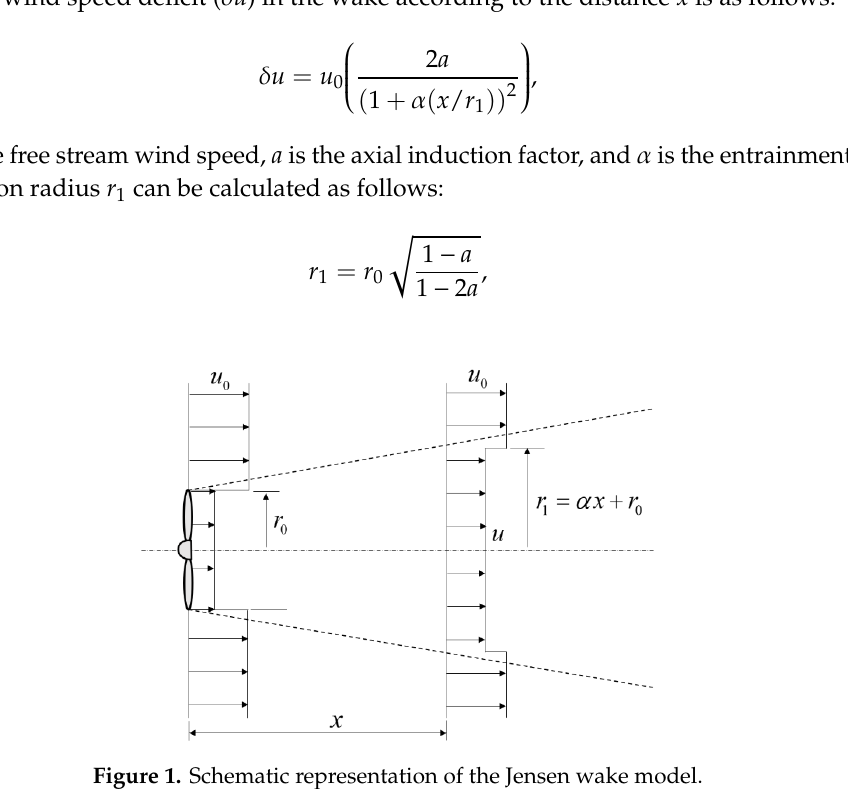
Figure 1. Schematic representation of the Jensen wake model.